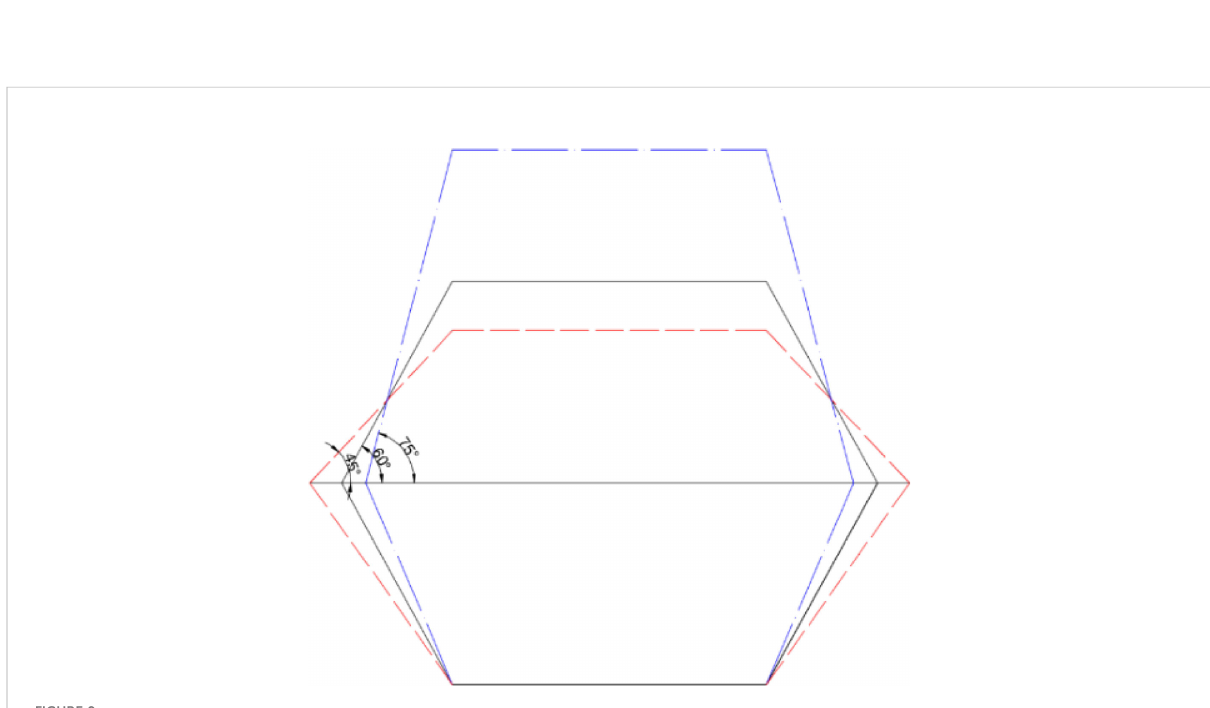
FIGURE 9 Schematic diagram of ice-breaking cone angle based on same collision location.